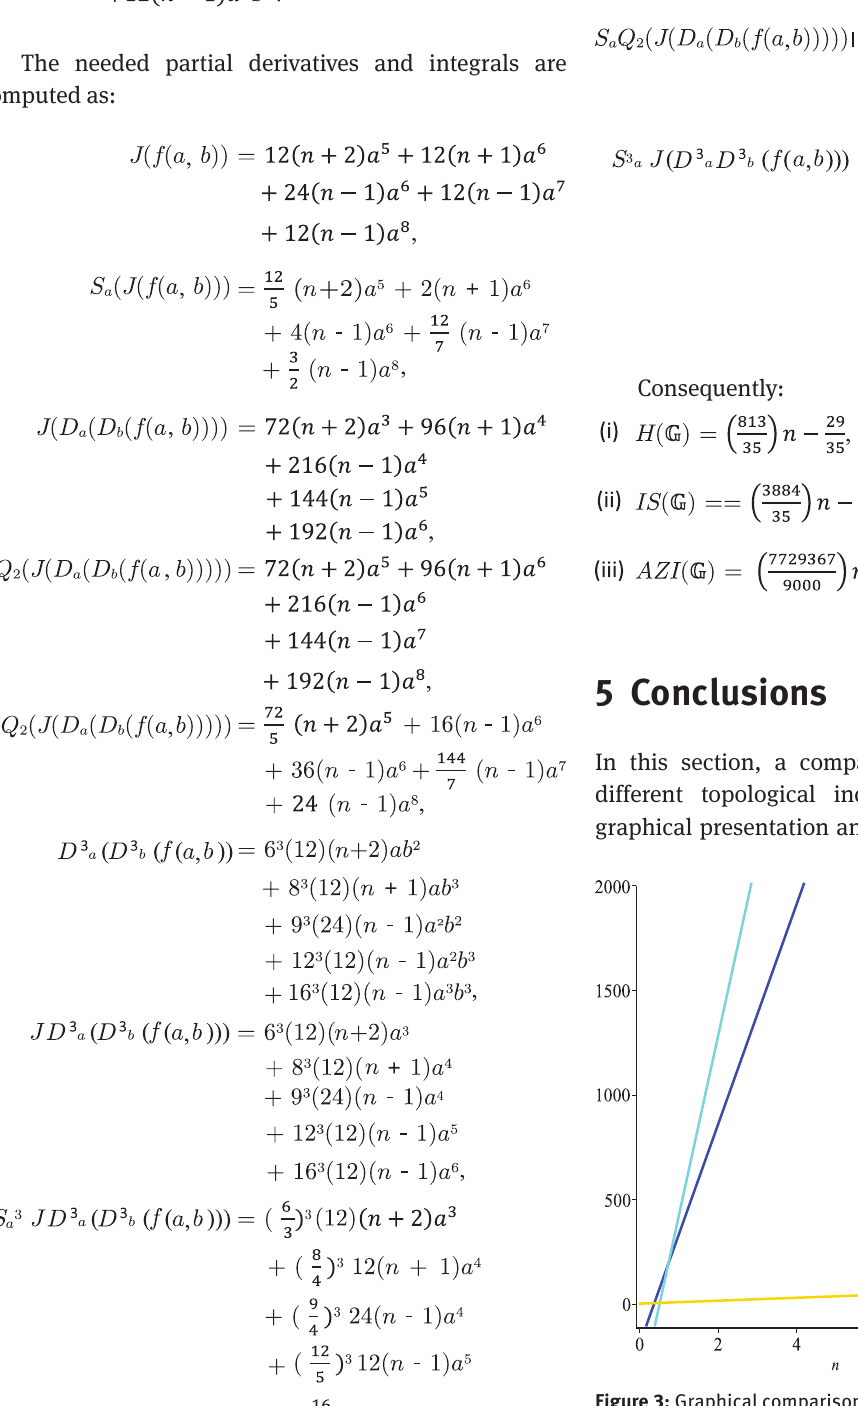
Figure 3: Graphical comparison of M labeled in blue, cyan, and gold graphs, respectively, for MON